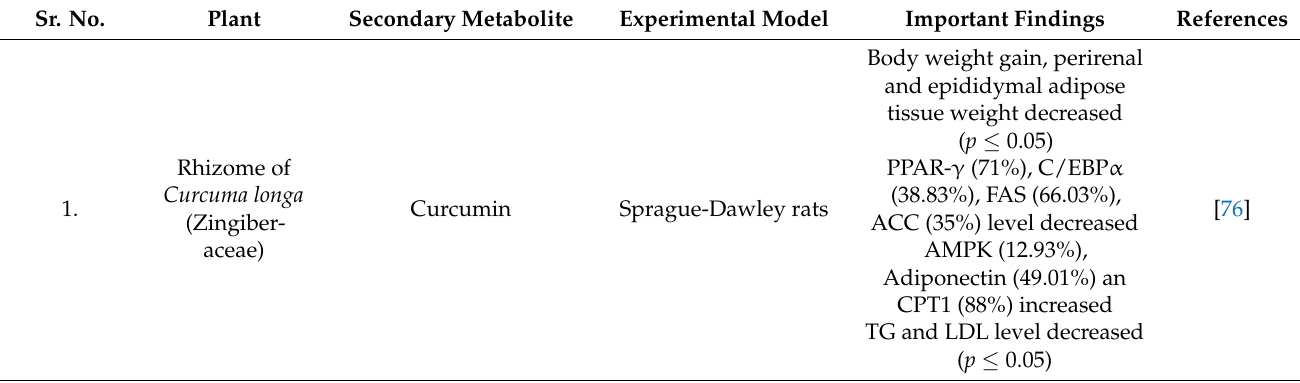
Table 1. List of different plants with anti-obesity effects with the list of secondary metabolites responsible for this biological activity. Sr.